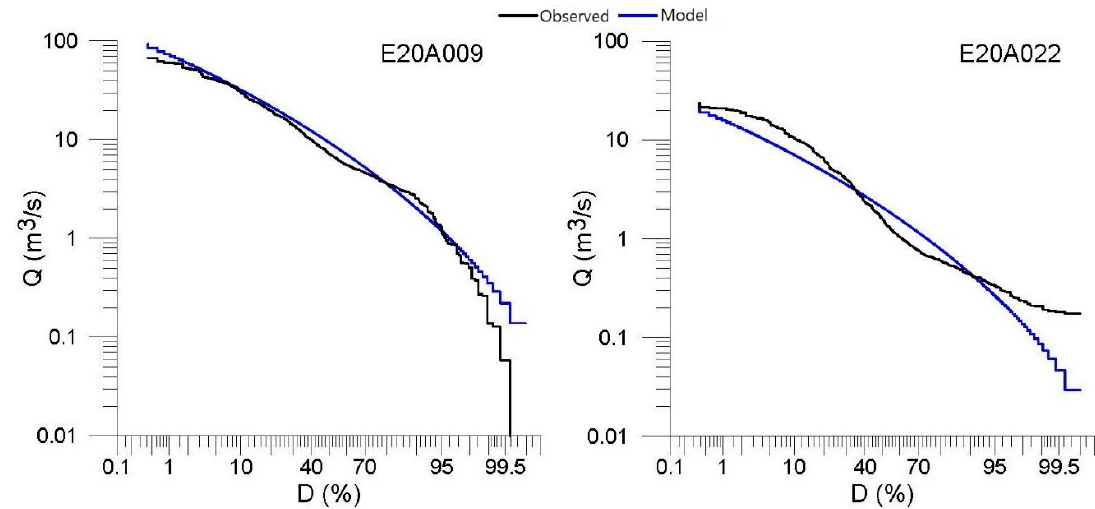
Figure 9. FDC of the monthly streamflow for validation gauging stations (continued).